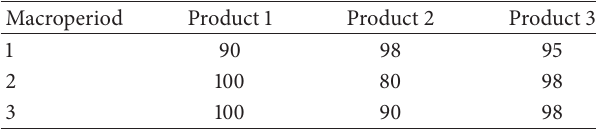
Table 2: Mean values of the product demand.